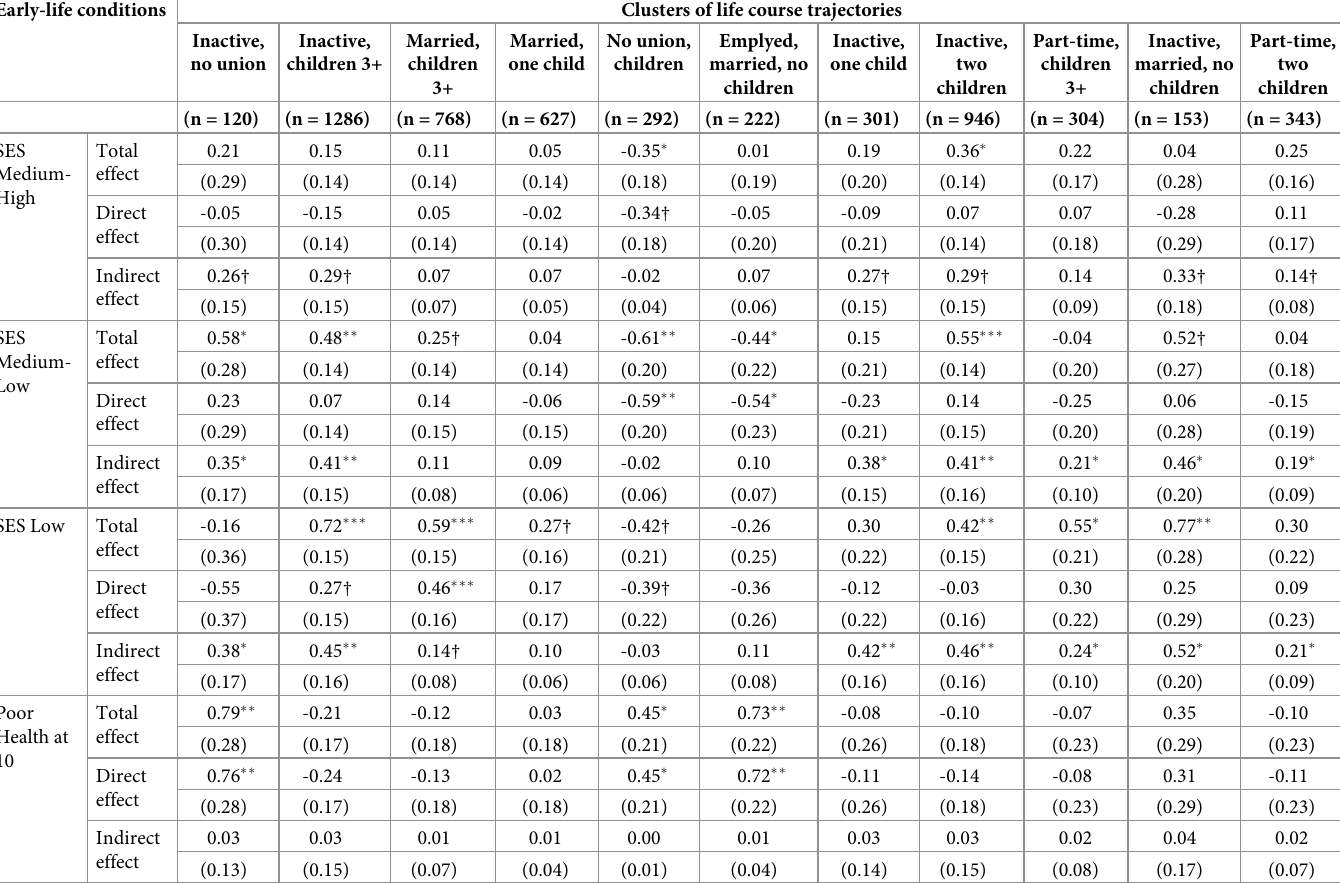
Table 3. Estimated multinomial regression coefficients (standard errors in parentheses) of SES and Health at 10 (early-life conditions) on clusters of life course tra- jectories and mediating effect of education. Women. (N = 6,221). Early-life